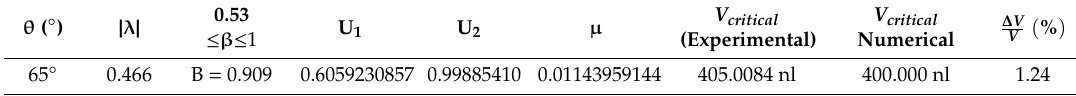
Figure A1. Computed morphology of the concave bridge: effect of the choice of parameter β .